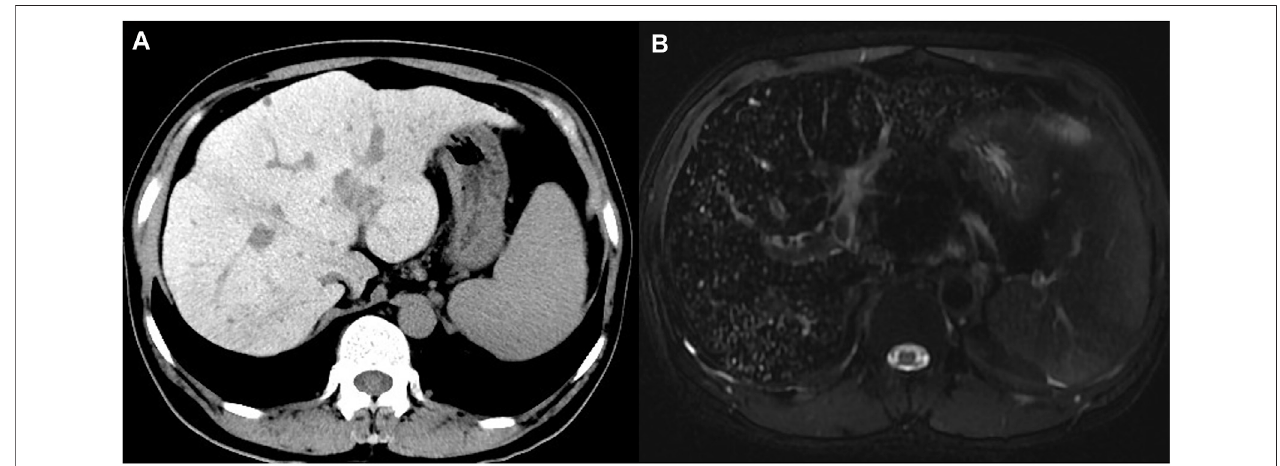
FIGURE 1 | Computed tomography and magnetic resonance imaging ofthe proband. (A) Precontrast CT showed hyper-attenuation of liver parenchyma; (B) MRI T2-weighted image showed diffuse low signal intensity of liver parenchyma obviously.